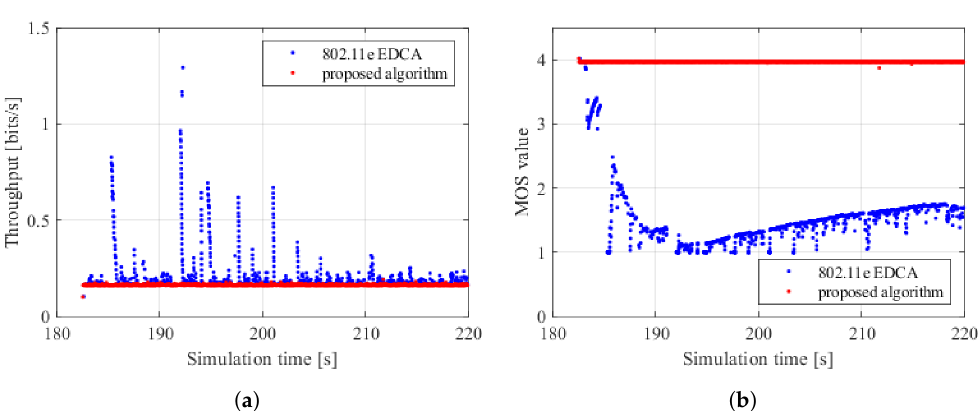
Figure 9. Performance comparison of voice application. ( a ) End-to-end delay. ( b ) MOS value.